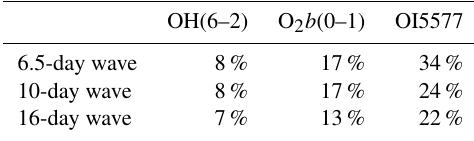
Table 1. Relative amplitudes induced by the 6.5-, 10-, and